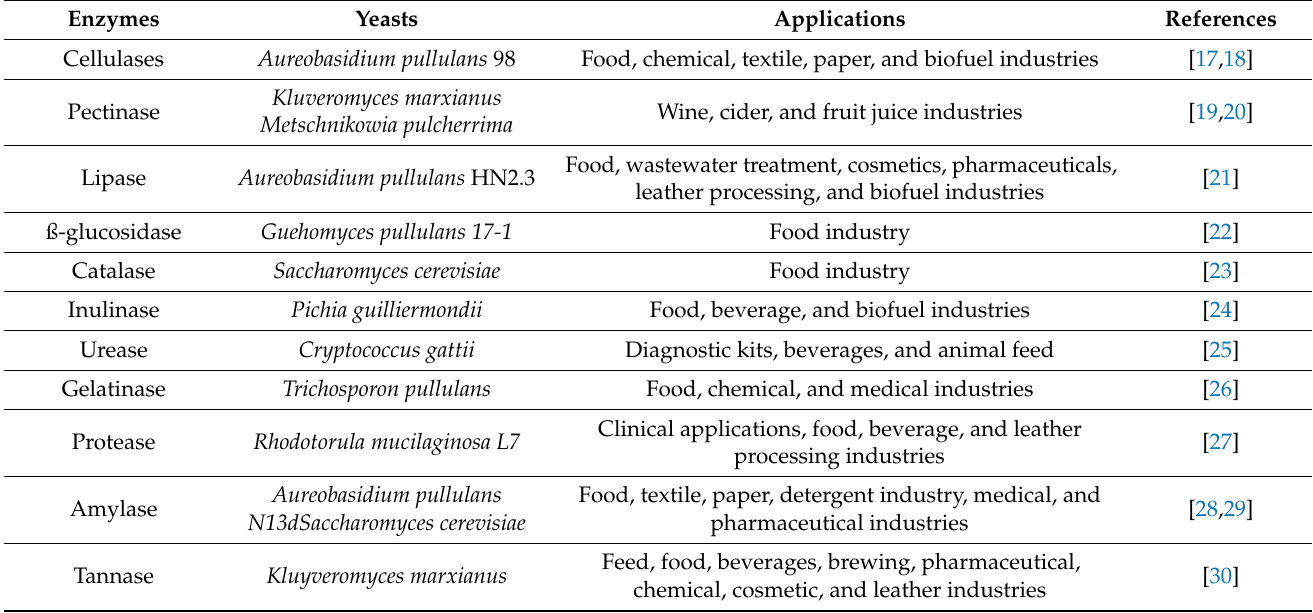
Table 1. Technological applications of yeast